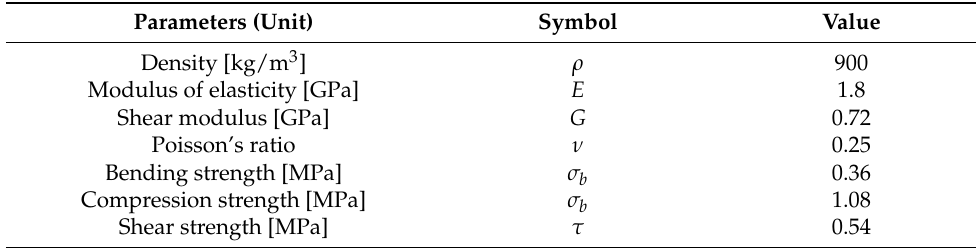
Table 1. Material Model Parameters of Ice